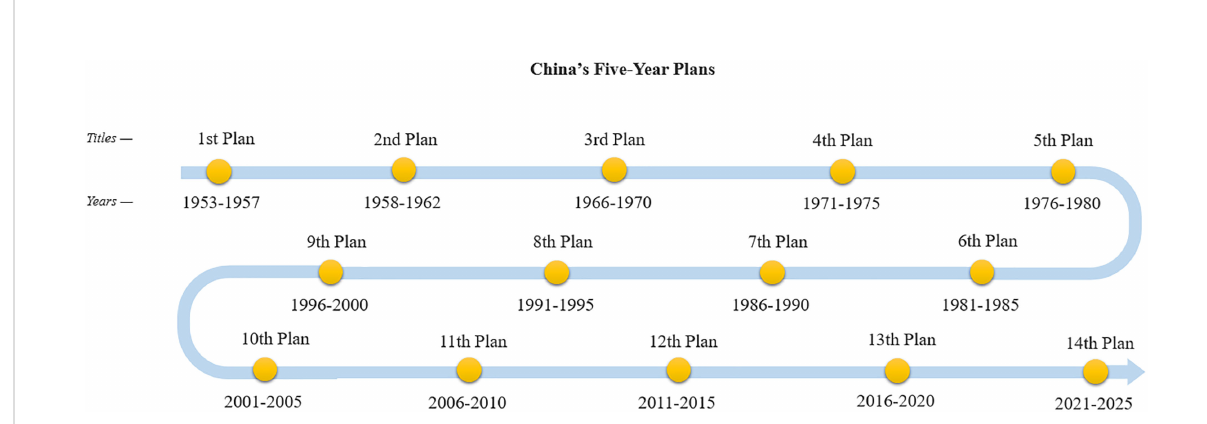
FIGURE 1 China ’ s Five-Year Plans. Source: Authors ’ compilation based on data from the website of the history of the People ’ s Republic of